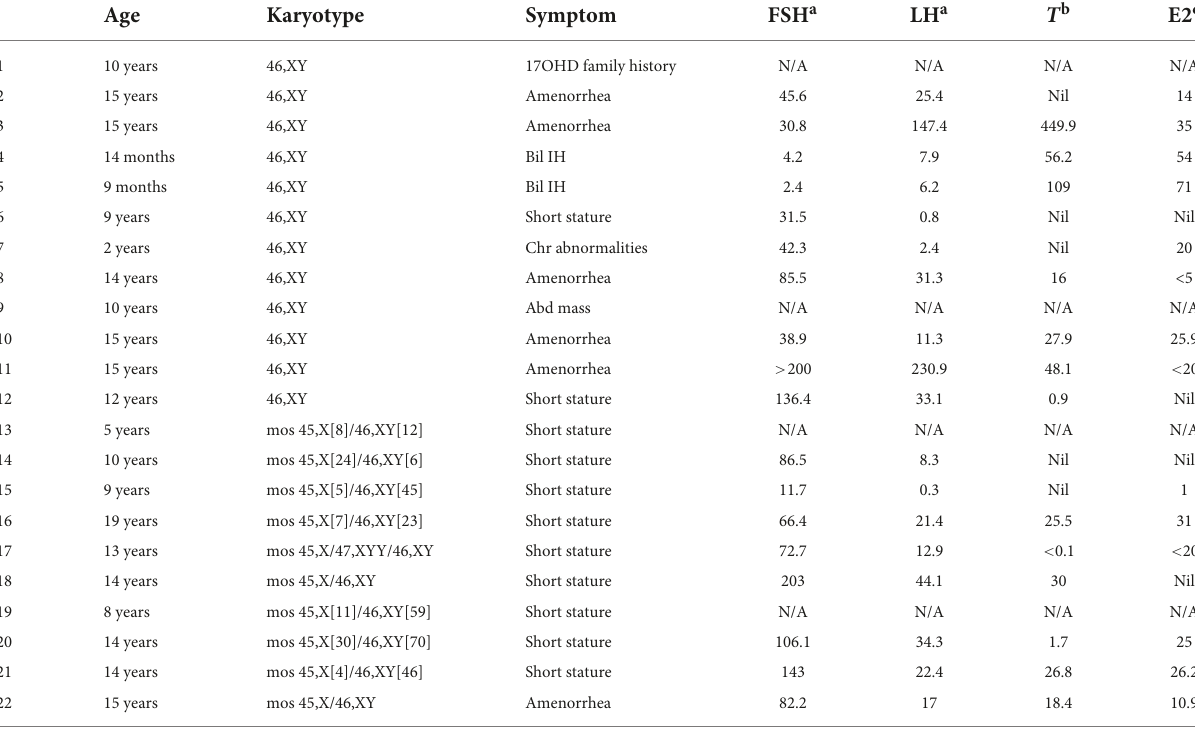
TABLE 1 Clinical presentations, hormonal profile, and karyotypes of the 22 phenotypic female patients with